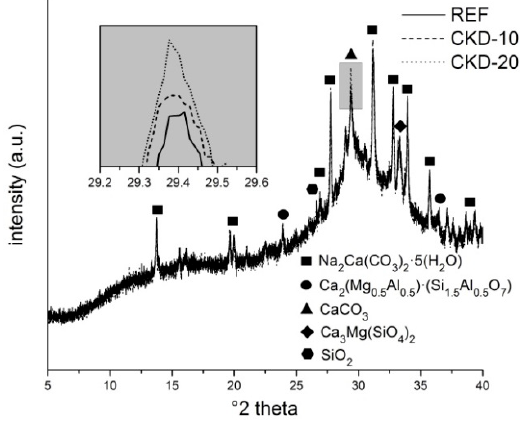
Figure 6. XRD of alkali-activated matrices with 0, 10 and 20 wt % of CKD addition.